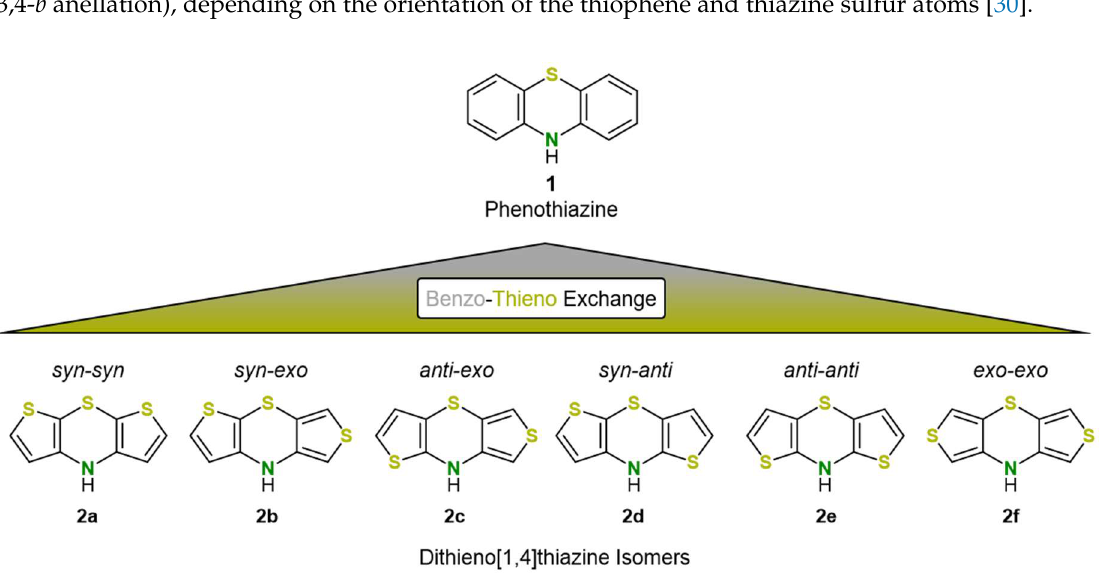
Figure 1. The six regioisomers 2 of the dithieno[1,4]thiazines derived from phenothiazine 1 by benzo-thieno exchange [30].